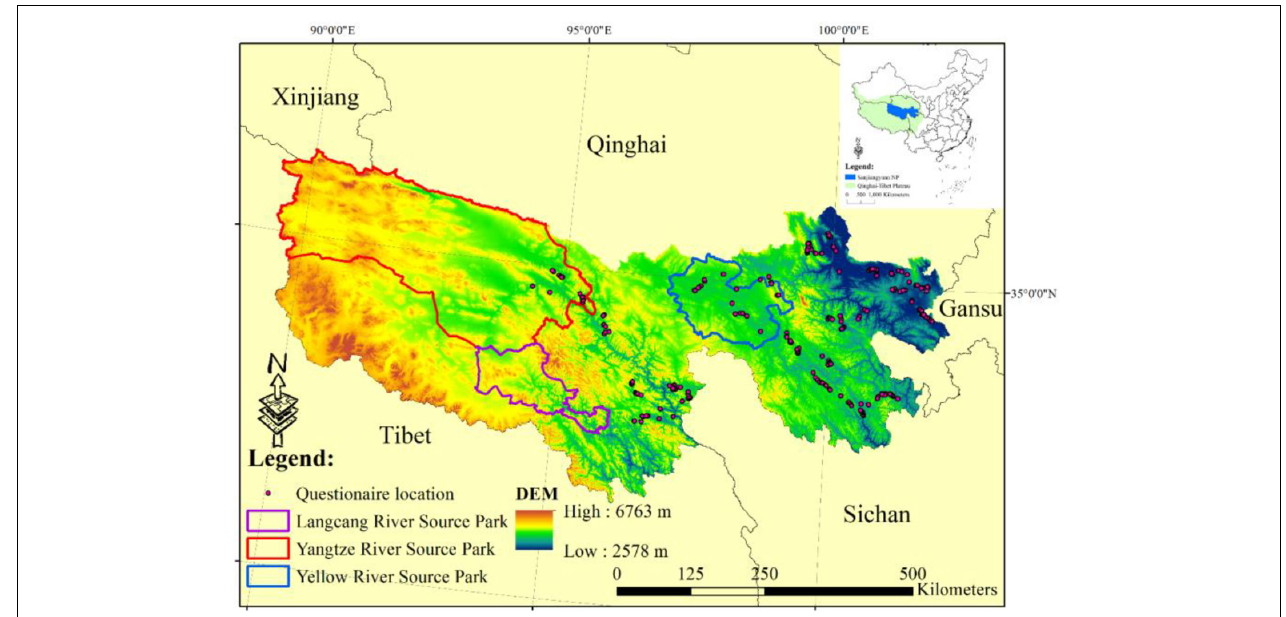
FIGURE 1 | Location of the study